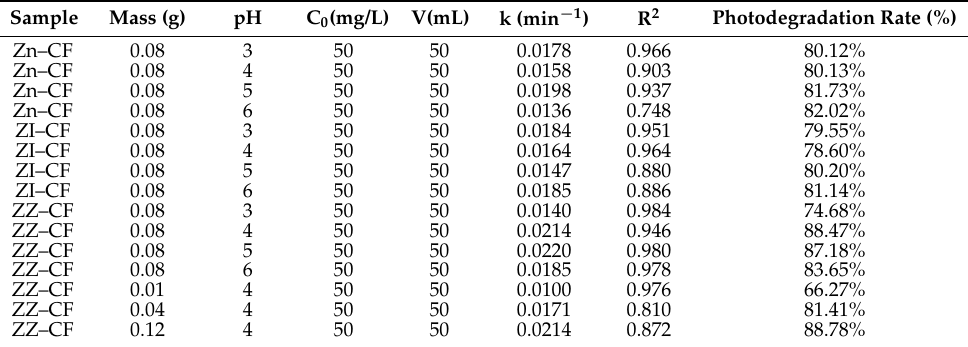
Figure 4. ( a – c ) Effect of initial solution pH; ( d – f ) first–order kinetic equation for Zn–CF, ZI–CF, and ZZ–CF, respectively; ( g ) Effect of photocatalyst dosage; ( h ) first–order kinetic equation with different dosage for ZZ–CF; ( i ) Cycling experiments with optimal pH and dosage of ZZ–CF. Table 1. Comparison of different samples’ performance to various pollutants.